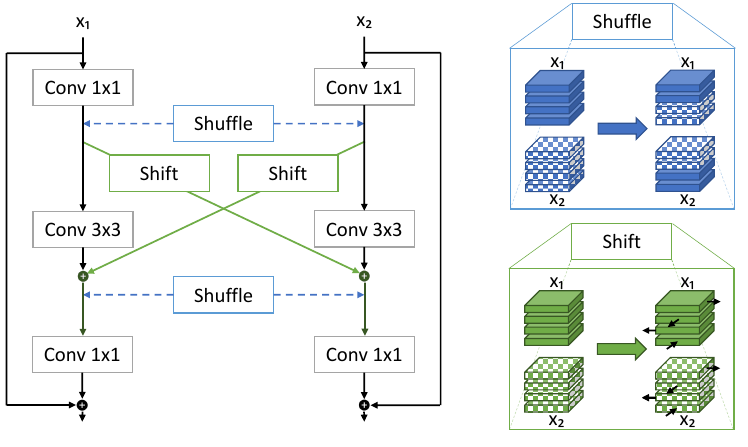
Figure 4. Asymmetric fusion block of